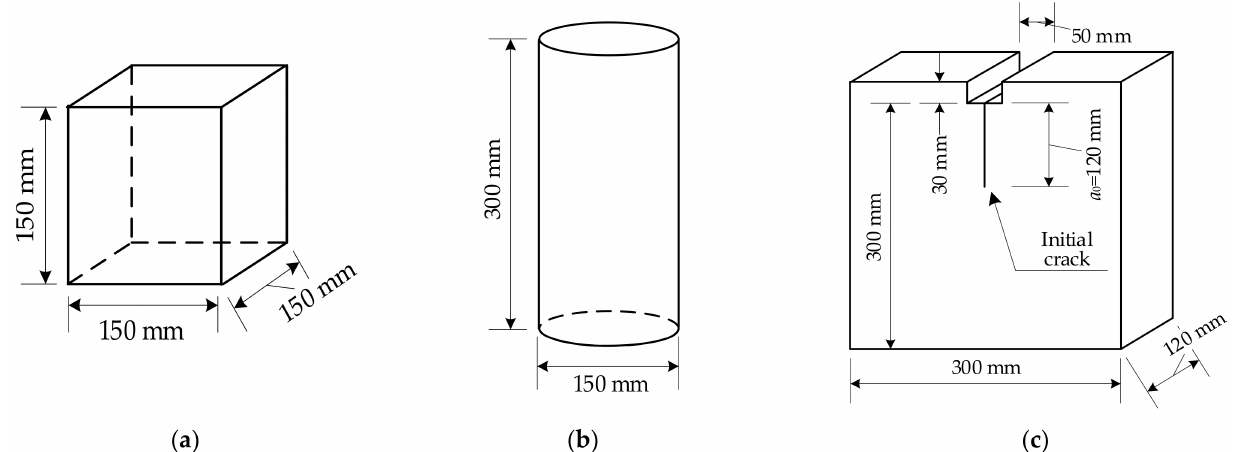
Figure 2. Three types of specimens cast on-site: ( a ) cube specimen; ( b ) cylinder specimen; ( c ) wedge- splitting specimen.